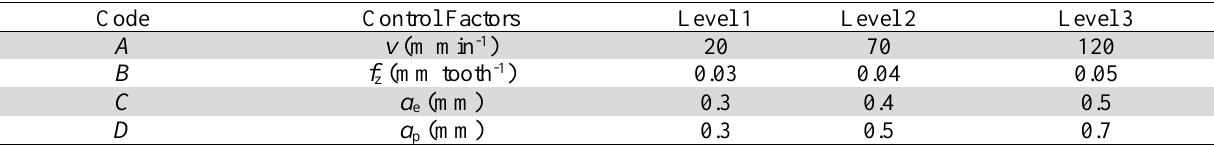
Control factors and